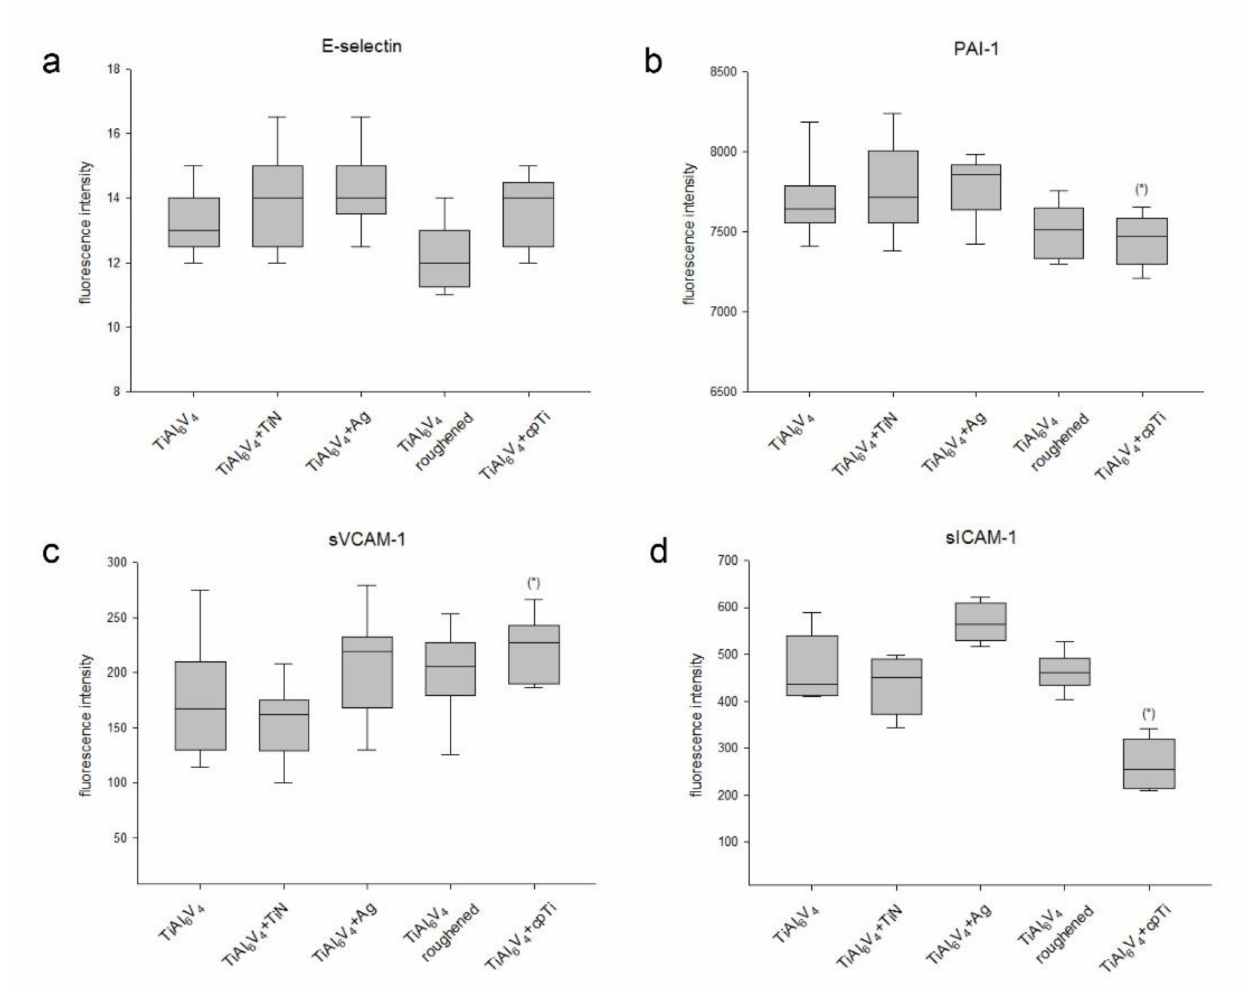
Figure 4. Expression of adhesion markers. The expression of six adhesion markers was analysed with the Luminex ® xMAP ® platform on uncoated TiAl 6 V 4 , titanium nitride (TiN) coated, silver coated (Ag), a roughened surface, and a pure titanium coated (cpTi) surface. The expression of ( a ) E-selectin, ( b ) PAI-1, ( c ) sVCAM-1, and ( d ) sICAM-1 was presented in box plots (mean ± SD; n = 8, measured in duplicates). P-selectin and PECAM were out of range. Statistical significance is defined as follows: * p <